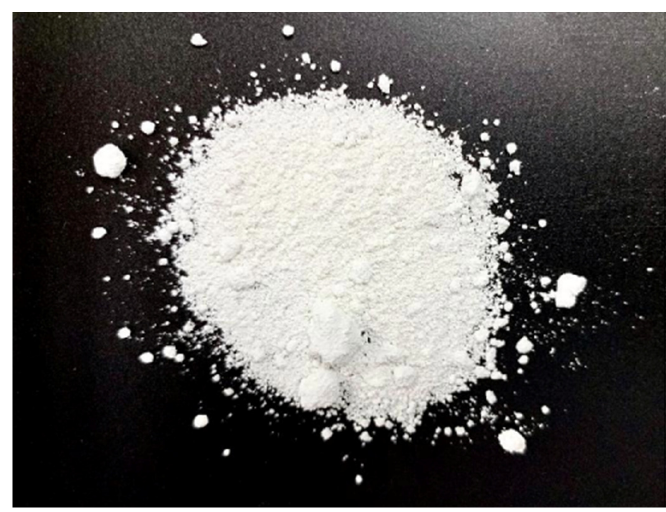
Figure 1. Reagent-grade TiO 2 powder (anatase, 99% purity).